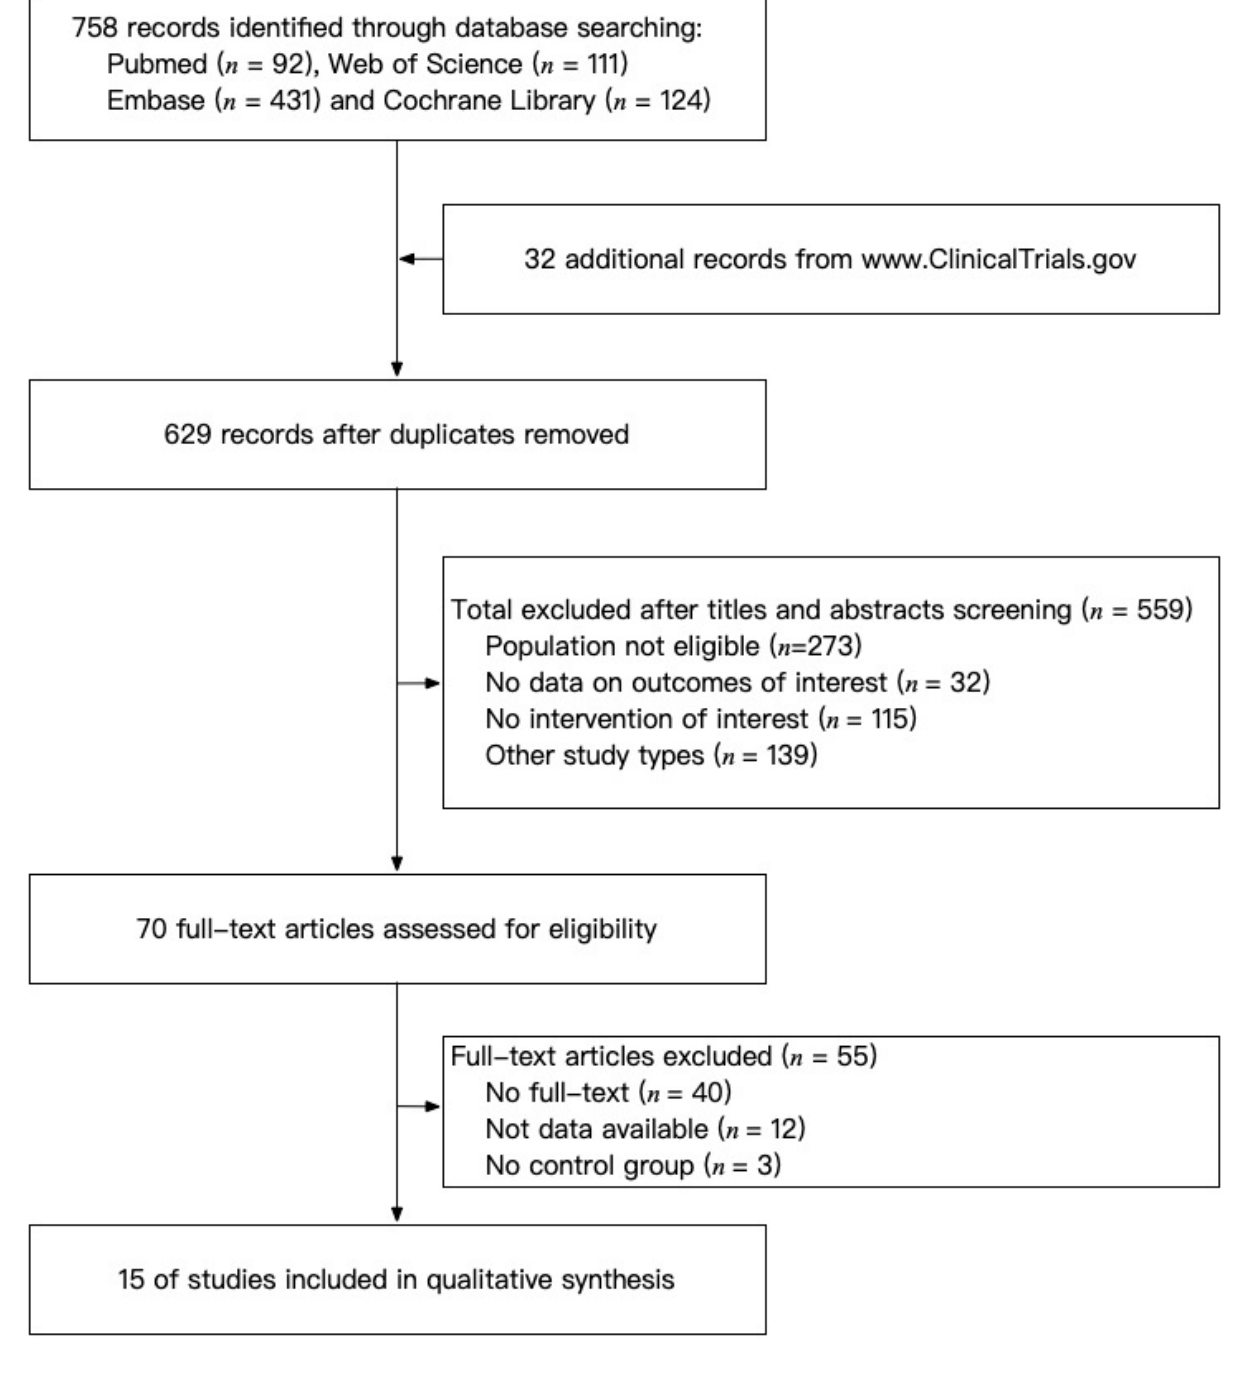
Figure 1. Detailed study selection process.